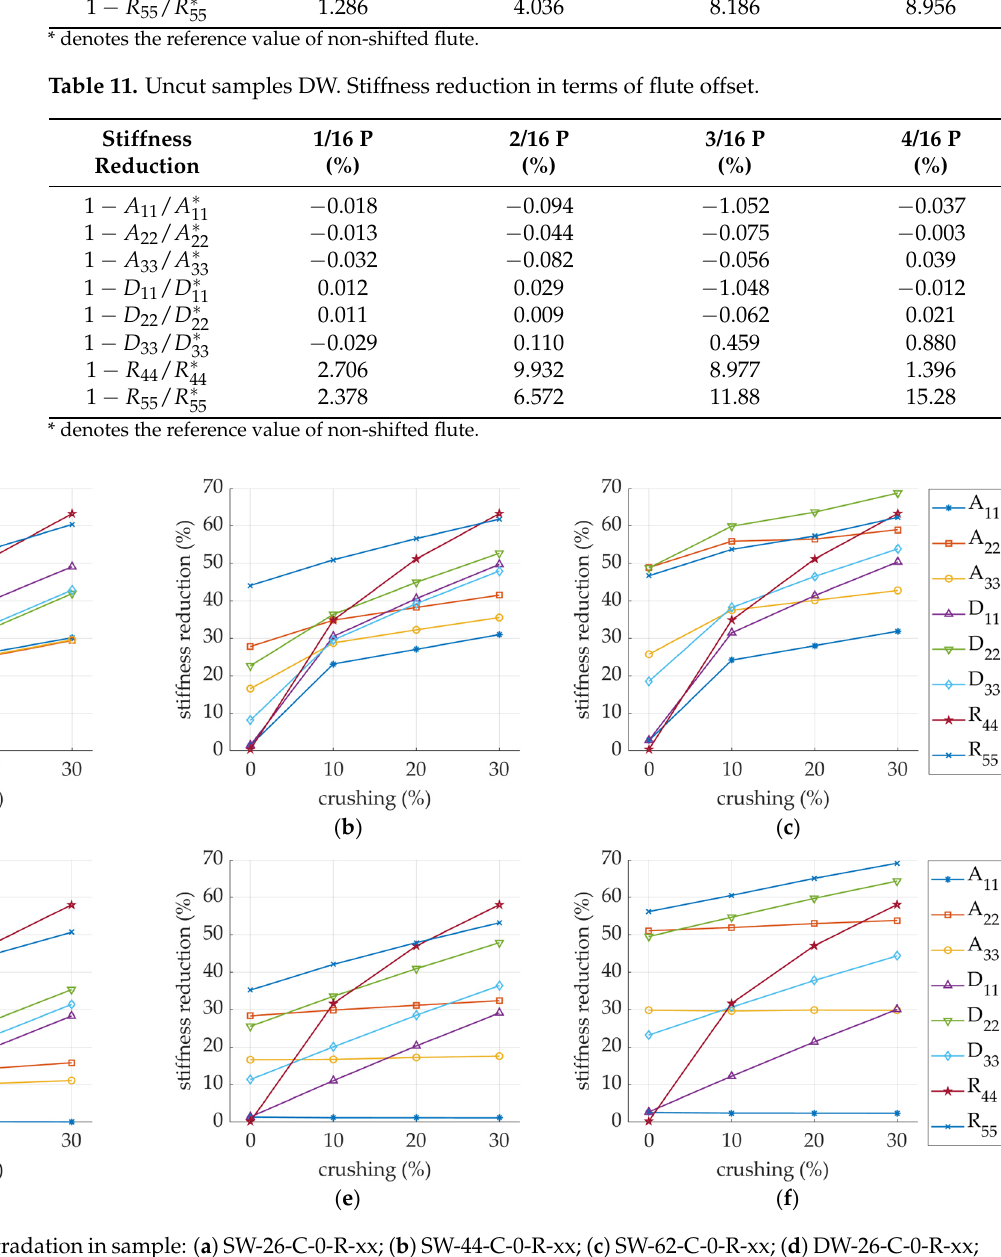
Table 11. Uncut samples DW. Stiffness reduction in terms of flute offset.